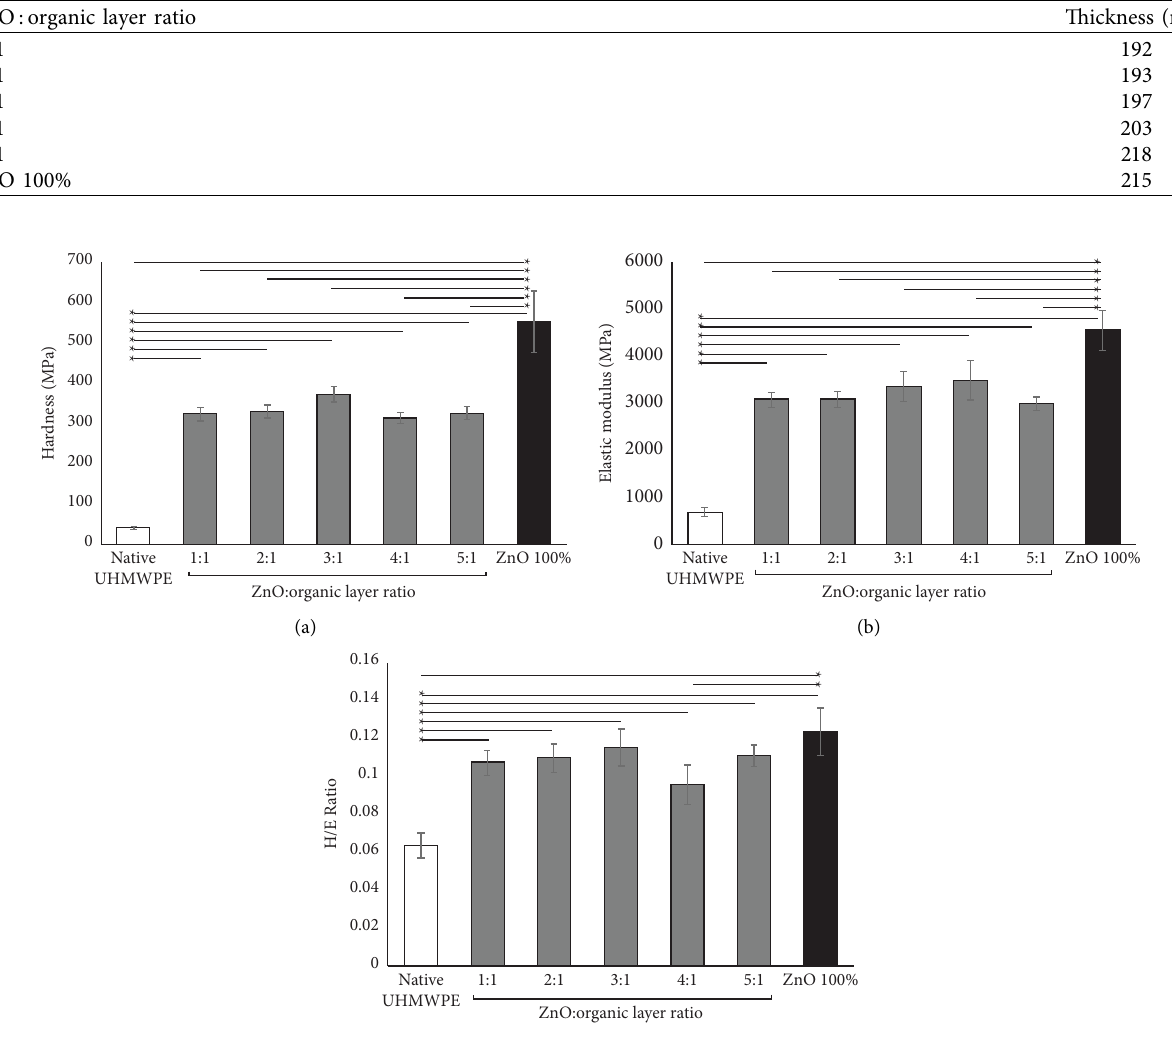
Table 1: Tickness of pure and hybrid ZnO flms.